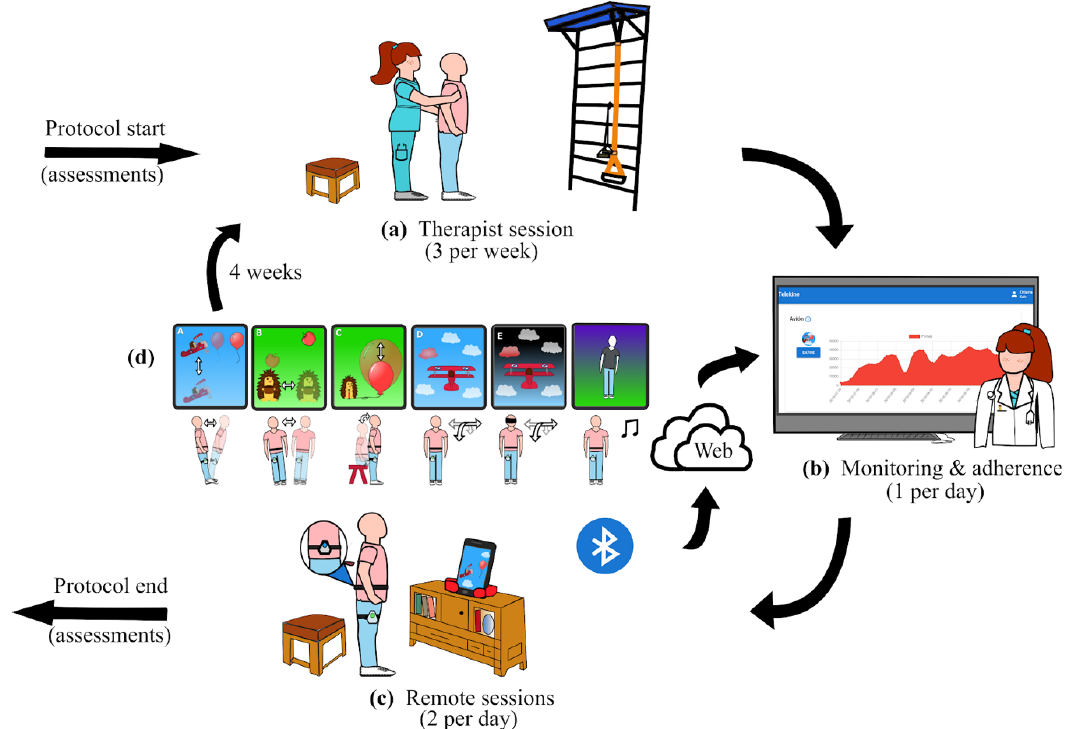
Figure 1. The proposed protocol: ( a ) The protocol started with a balance assessment and a therapist session at the hospital’s physical therapy unit, followed by rehabilitation sessions 3 times per week; ( b ) after equipment delivery as well as participant and caregiver training, the therapist remotely monitored home progress using the web platform; ( c ) the participant exercised at home using the proposed system while games scores and IMU recordings were sent to the platform database for monitoring; ( d ) after 4 weeks, the protocol ended by repeating the balance assessment.